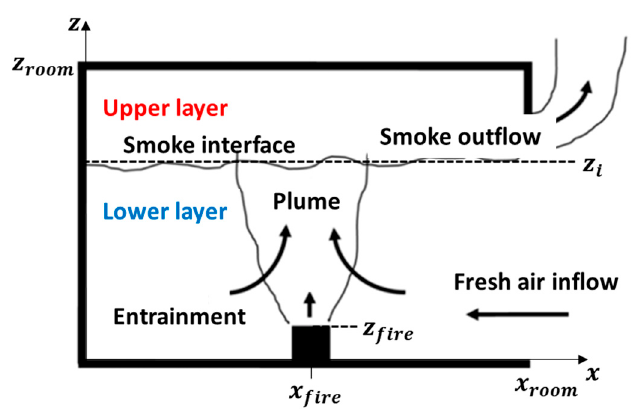
Figure 1. Schematic of the two-zone model in the plane y = y fire .